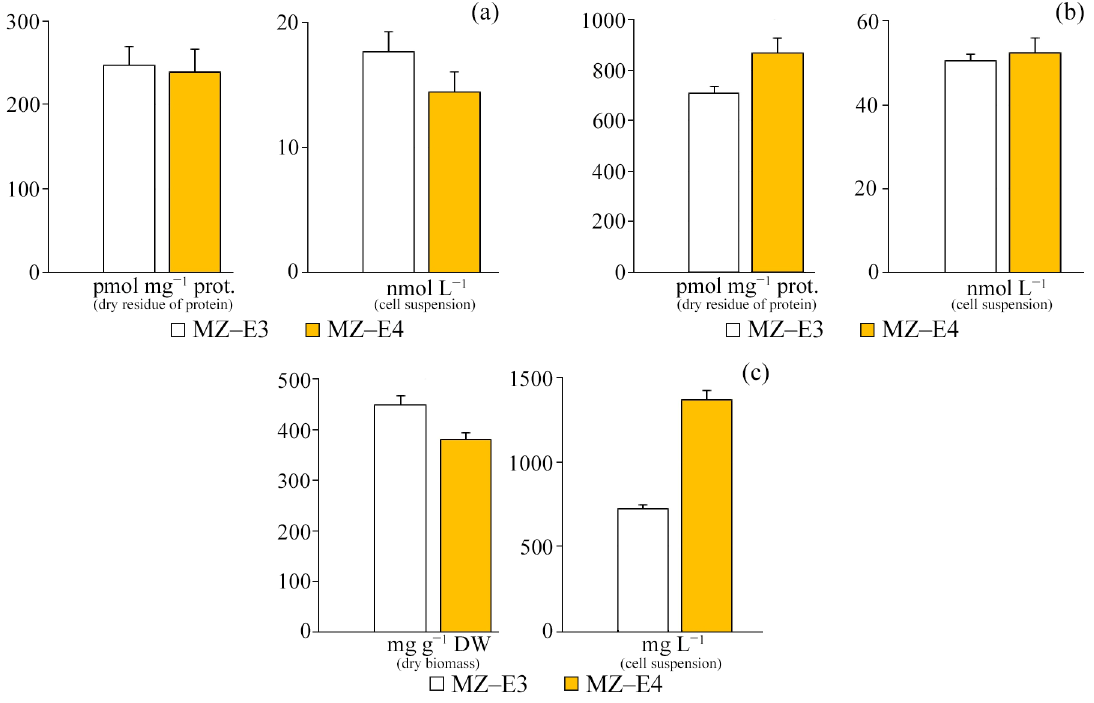
Figure 5. TBA-active products and protein content on the dry residue of protein and cell suspension of Vischeria vischeri strains (MZ–E3; MZ–E4). ( a ) TBAaP. ( b ) TBAaP in . ( c ) Protein. Medium: BBM; culture volume: 250 mL; incubation time: 25 days; M ± S.E., n = 3.